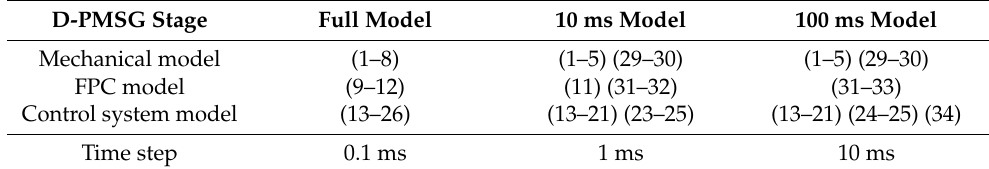
Table 2. Summary of the D-PMSG models.